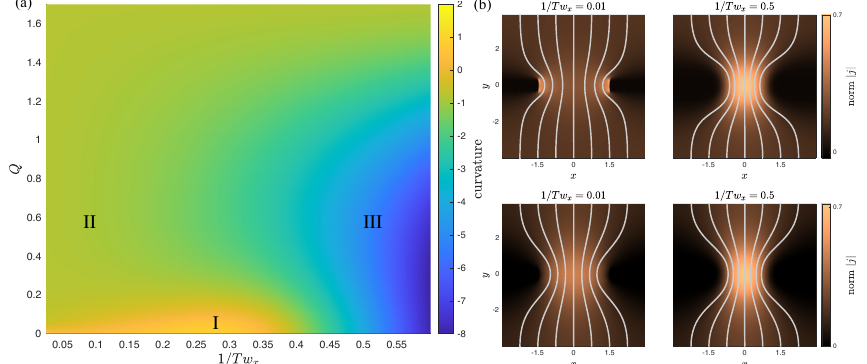
Figure 9: (a): curvature of the current profile at the constriction center, given by d 2 | j | ( y = x = 0 ) / d x 2 , against T and Q . Here Q reparameterizes µ via Q ∝ µ r + , 4 π Tr + = 3 − µ 2 r 2 . There are three different regimes: (I) the Ohmic regime, (II) the + viscous regime, and (III) the quantum crtical regime. (b): 2D current distribution = 0.01 and 0.5 with the same slit width as in the main and streamlines for 1 / Tw x text. The top line is at zero density ( Q = 0), while the bottom line is at finite density ( Q =